Question: What kind of plot is shown here?
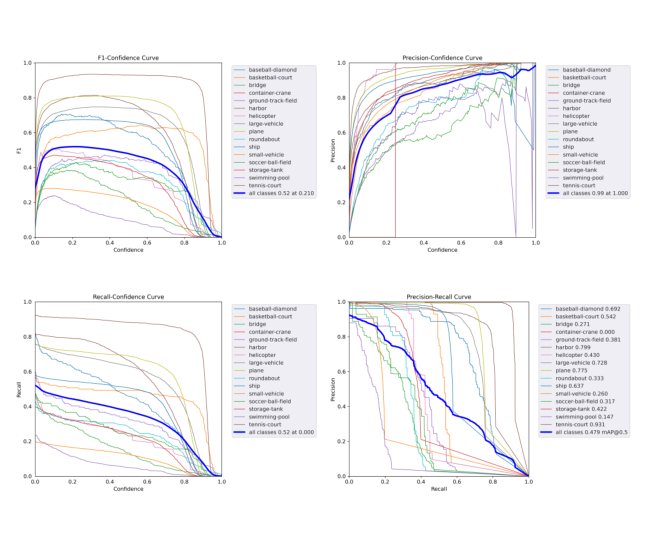
Answer: line